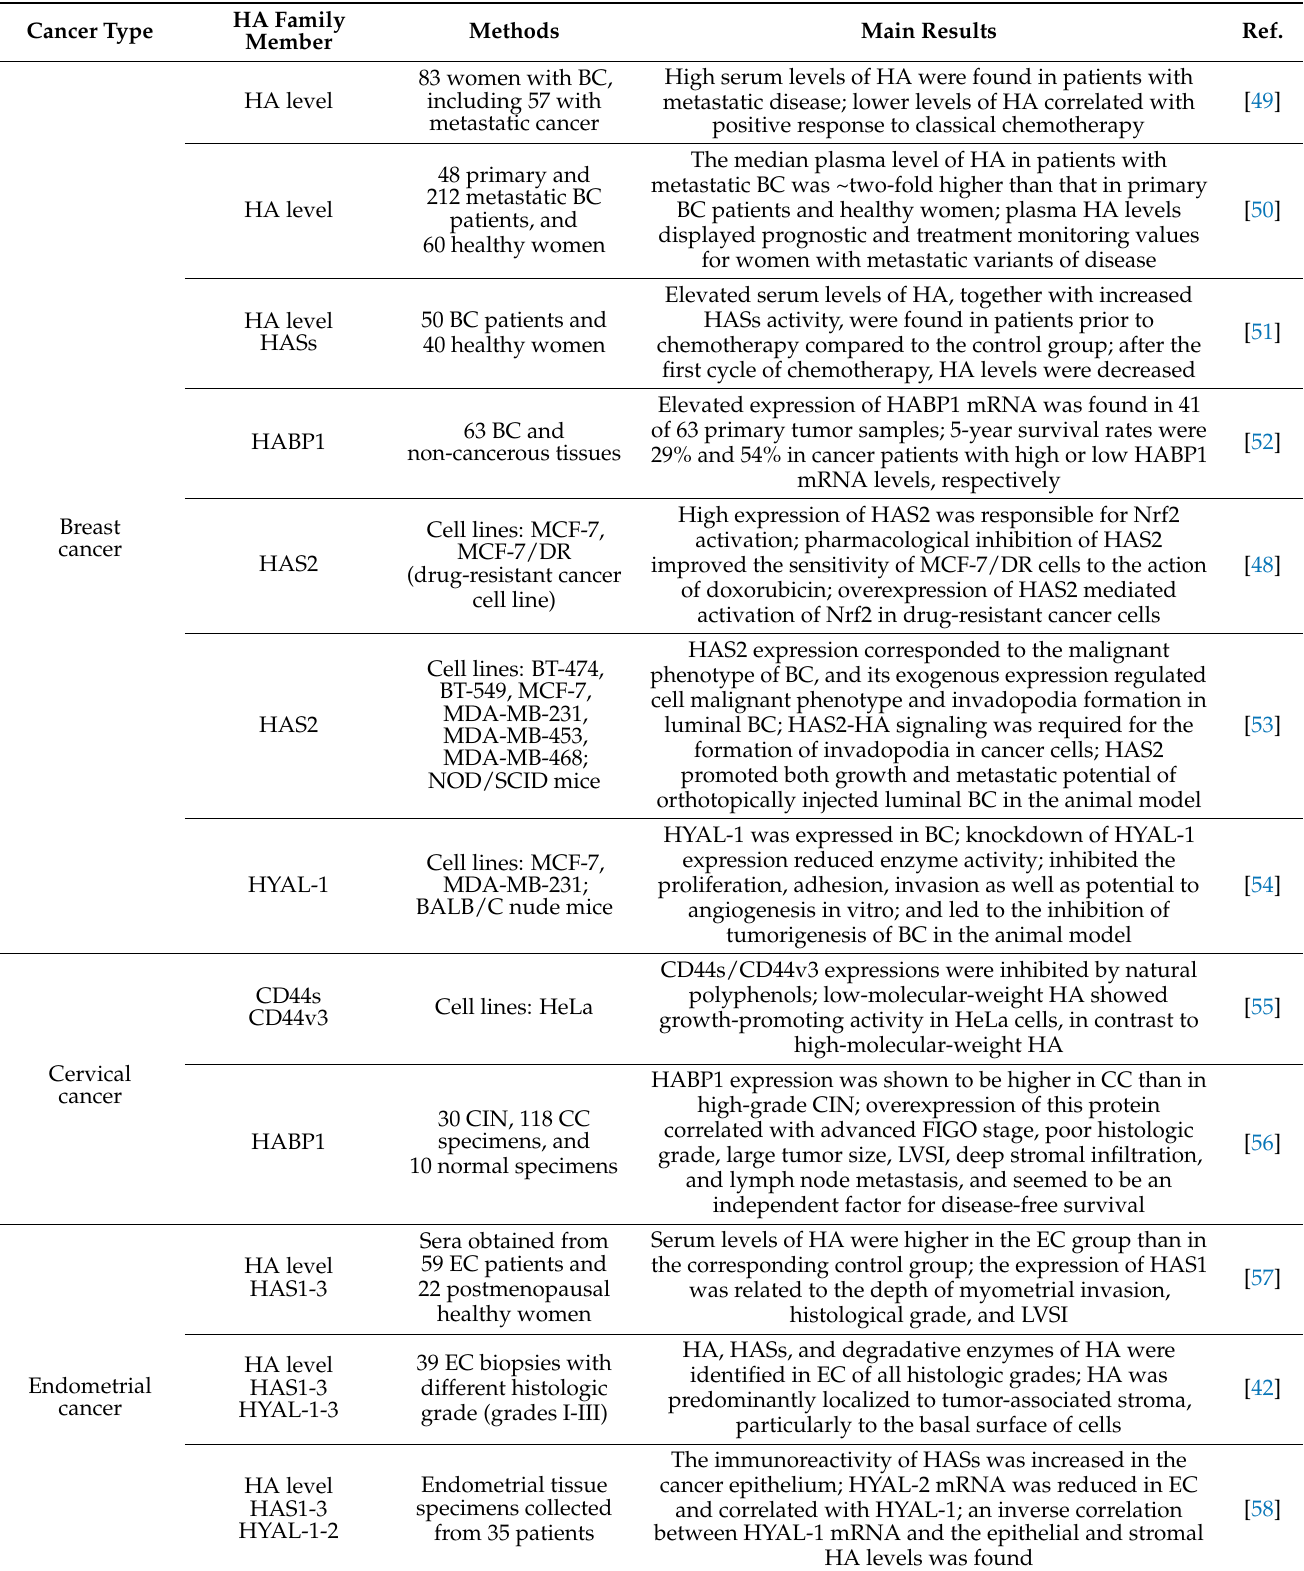
Table 1. Original studies on the role of HA and its family members in gynecological